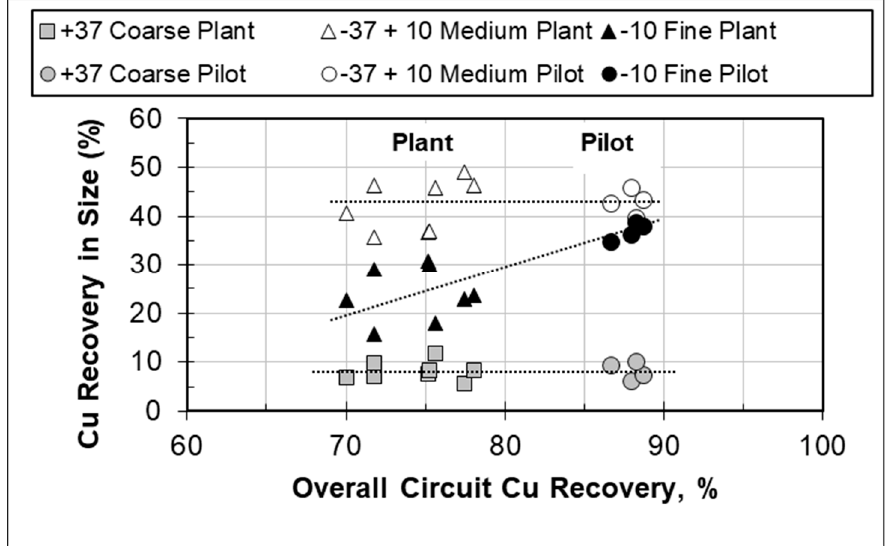
Figure 3. Comparison of Cu recovery by fraction between plant and pilot tests. A series of cell characterization tests establishing the D 32 versus J g relationship were performed for both the pilot and the plant cells (plus a few comparative Denver lab cell tests), and the results are shown in Figure 4. The calculation of S b (according to Equation (3)) for the pilot and plant cells shows that the pilot cells produce a significantly smaller bubble size (D 32, 1.35 mm vs. 1.85 mm at J g = 1 cm/s) and, therefore, a correspondingly higher bubble surface area flux ( S b , 50 1/s vs. 30 1/s at J g = 1 cm/s) for an equivalent amount of air.